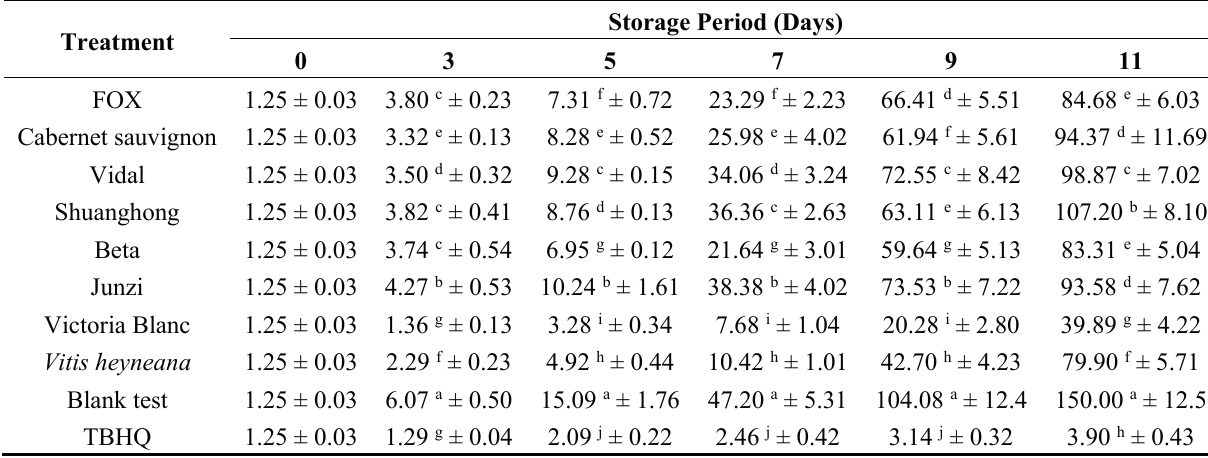
Table 2. POV (meqO 2 /kg sample) of edible oils samples treated with TBHQ and grape polyphenol extracts from canes with petroleum ether antioxidation test at 70 ± 1 °C, kept in the